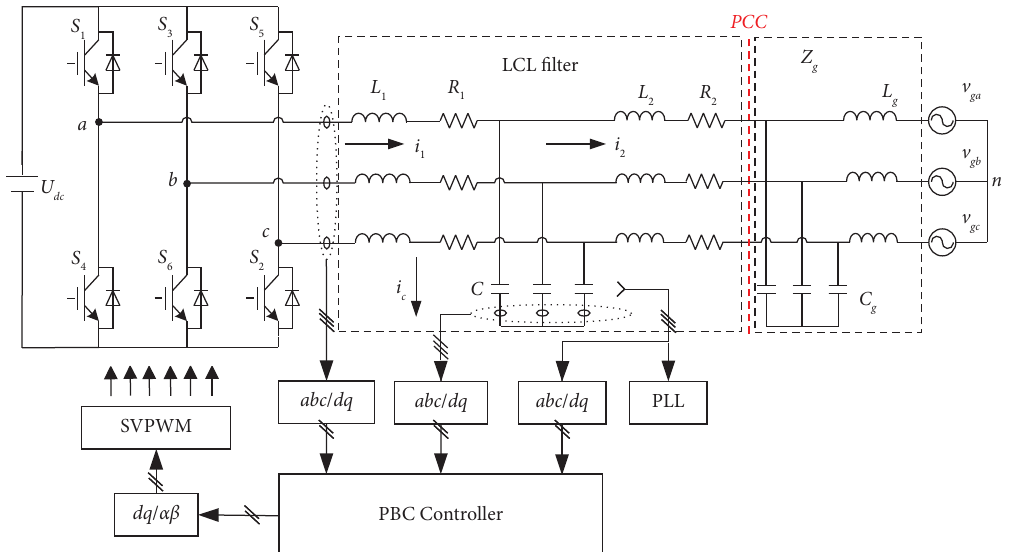
Figure 1: Confguration of LCL-fltered three-phase grid-tied VSI based on PBC with inverter-side current